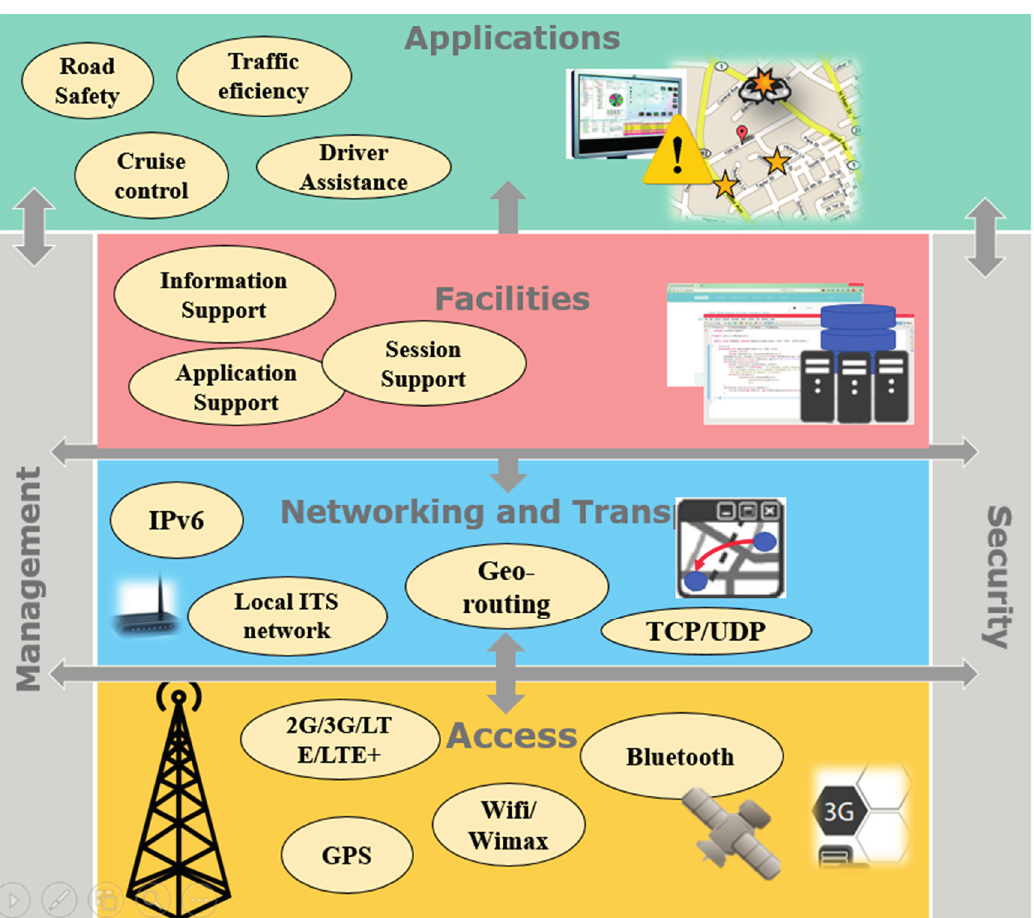
Figure 3. Main components in ITS systems